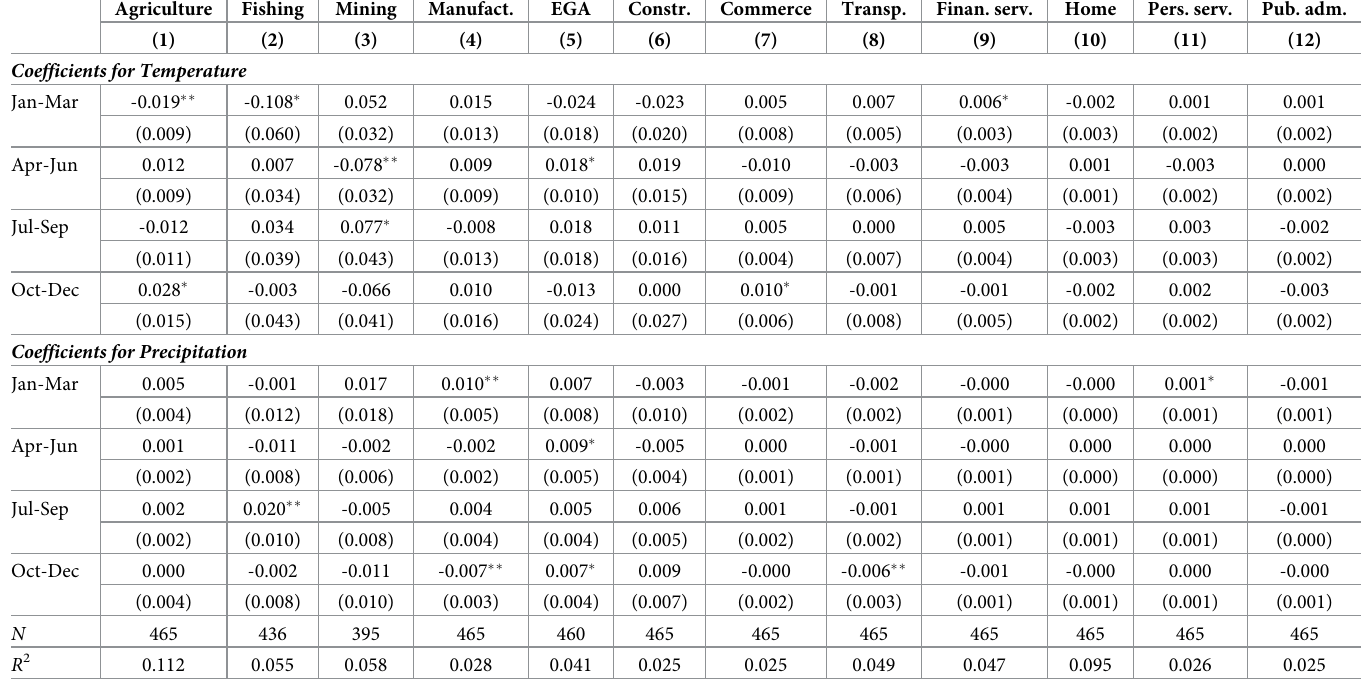
Table 4. Coefficients for the impact of temperature and precipitation (quarterly averages) on regional industry GDP: OLS with fixed-effects by time and region, sep- arate regressions by industry.